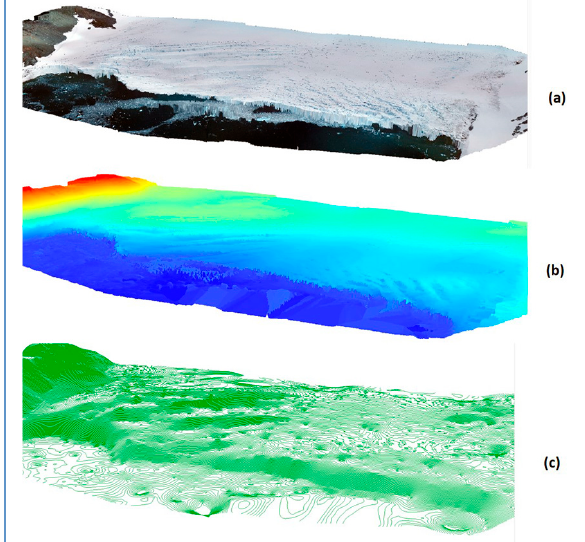
Figure 6. Views of the LG (a) Ortomosaic in 3d, (b) Digital model of elevation in 3d and (c) Level curves with an an interval of 10 meters in 3d. (Figure 7a-b), which may correspond to moraines by the glacial rock drag, sediments, and detritus deposited in the bay. These findings suggest that the front of the glacier has retreated from the past location. Indeed, the current LG front length showed a notable 600 m retreat in comparison to observations of Barboza et al . (2004) on LG front length 20 years ago.